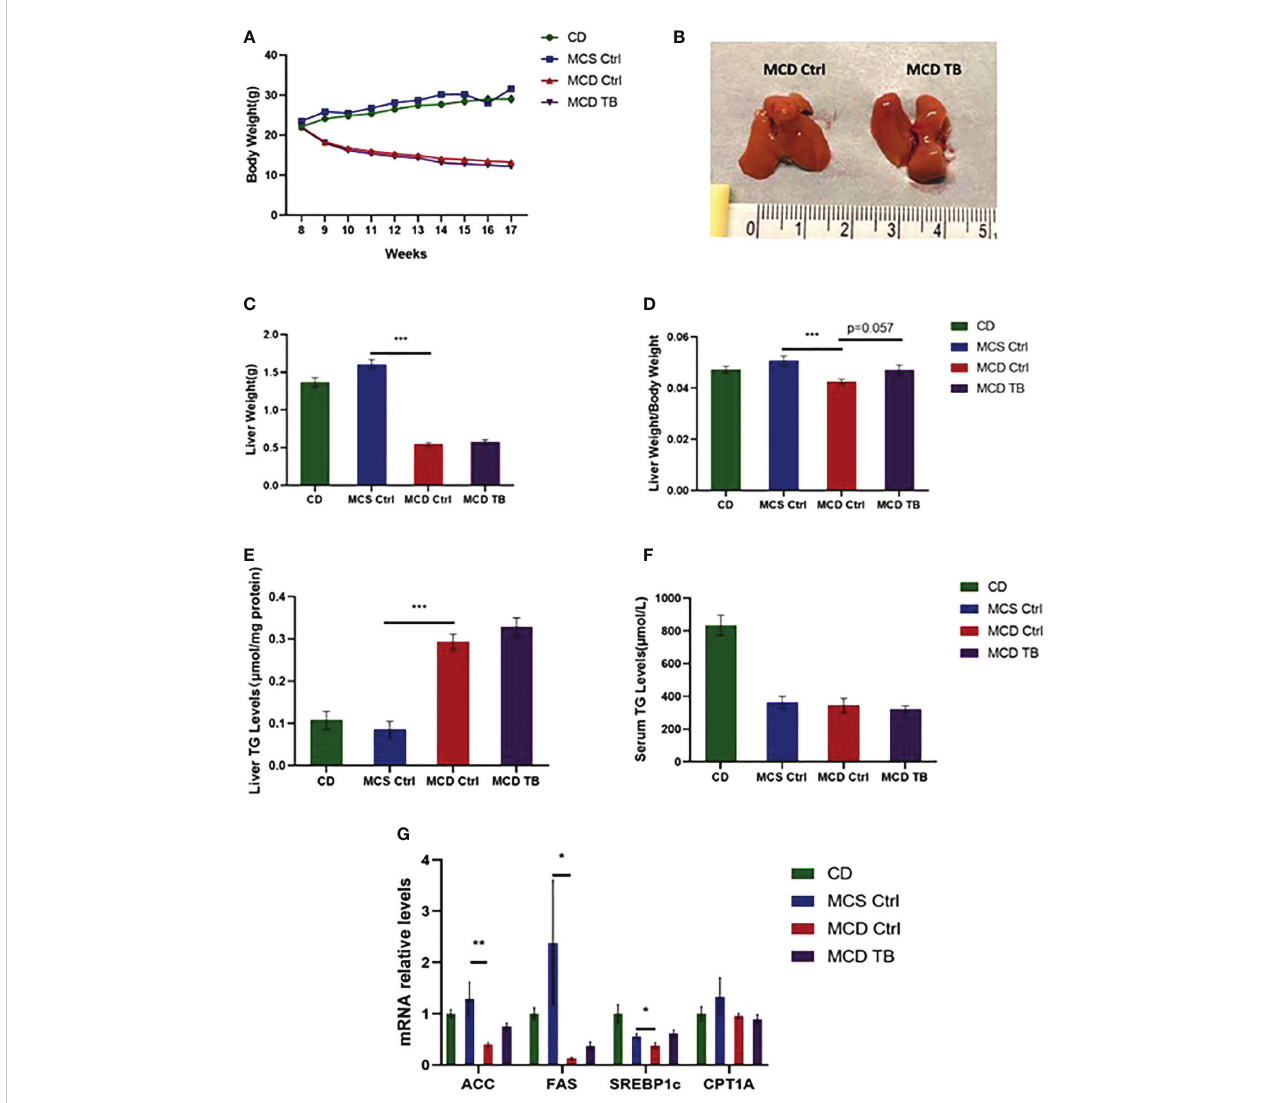
FIGURE 1 Theabrownin does not change body weight, liver weight and liver lipid deposition in MCD diet-fed mice. (A) The change of body weight. (B) Liver morphology. (C) Liver weight. (D) Liver coef fi cient. (E) Liver TG level. (F) Serum TG level. (G) mRNA levels of ACC, FAS, SREBP1c, and CPT1A. n=5-11 mice per group. The data are mean ± s.e. (error bars). *p < 0.05, **p < 0.01, ***p < 0.001, MCS Ctrl vs MCD